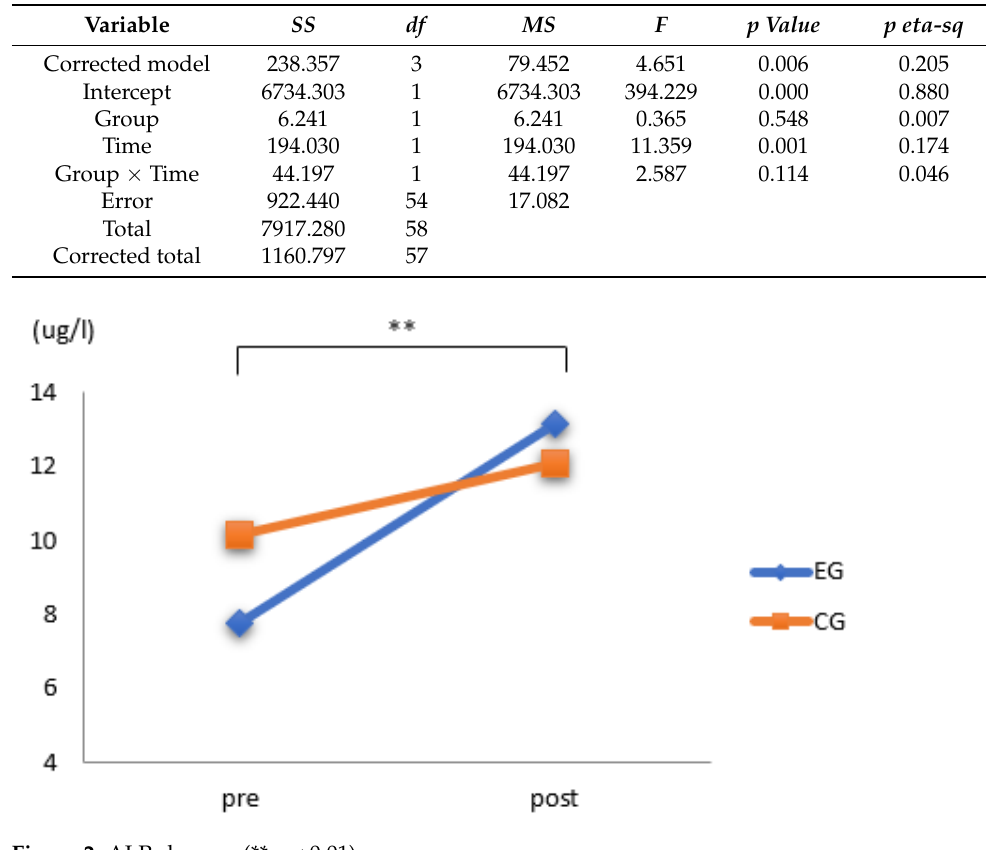
Figure 2. ALP changes (** p < 0.01).